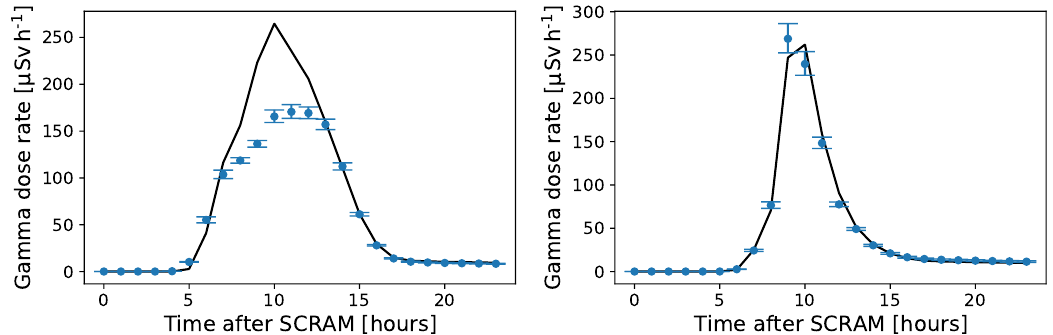
Figure 5. Gamma dose rates at locations of gamma stations during the first 24 h after the accident. Model predictions with uncertainties (median and 10th and 90th percentile) are shown by the blue dots and error bars, while the true gamma dose rates are shown by the black solid line. The selected gamma stations are all close to release locations, viz. the six stations that measured the highest values during the first 24 h.